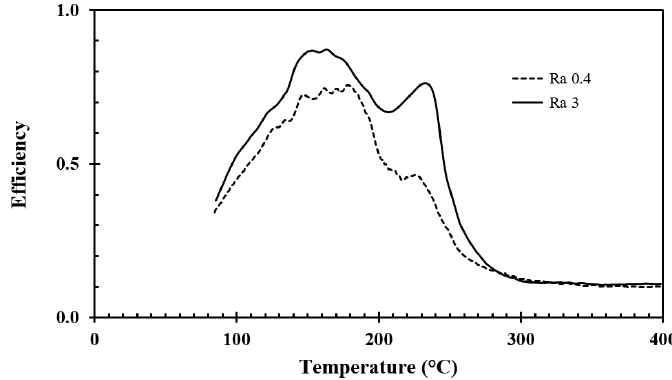
Figure 11. Average cooling efficiency for water droplets impinging onto the stainless steel disc with surface roughnesses of Ra 0.4 and Ra 3 (marked on the figure).